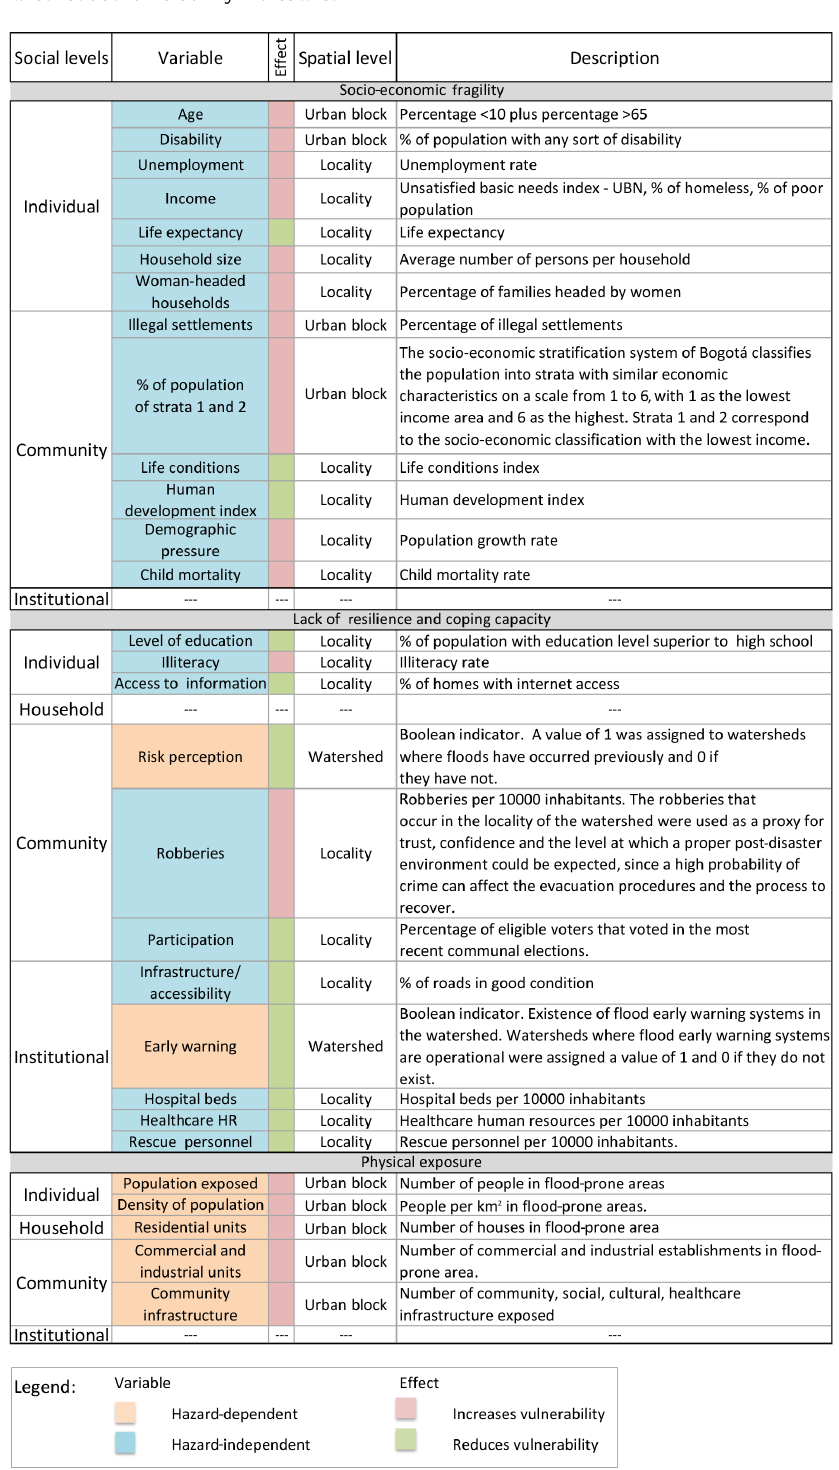
Table 2. Variables used to construct vulnerability